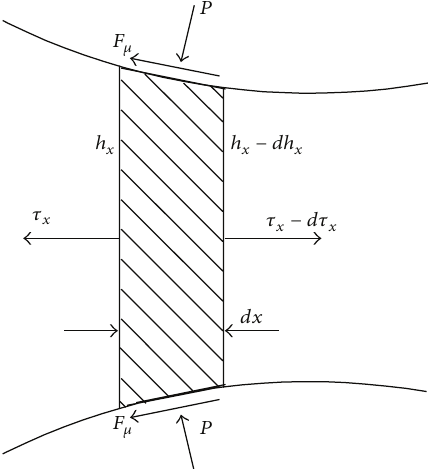
Figure 2: The pressure diagram of